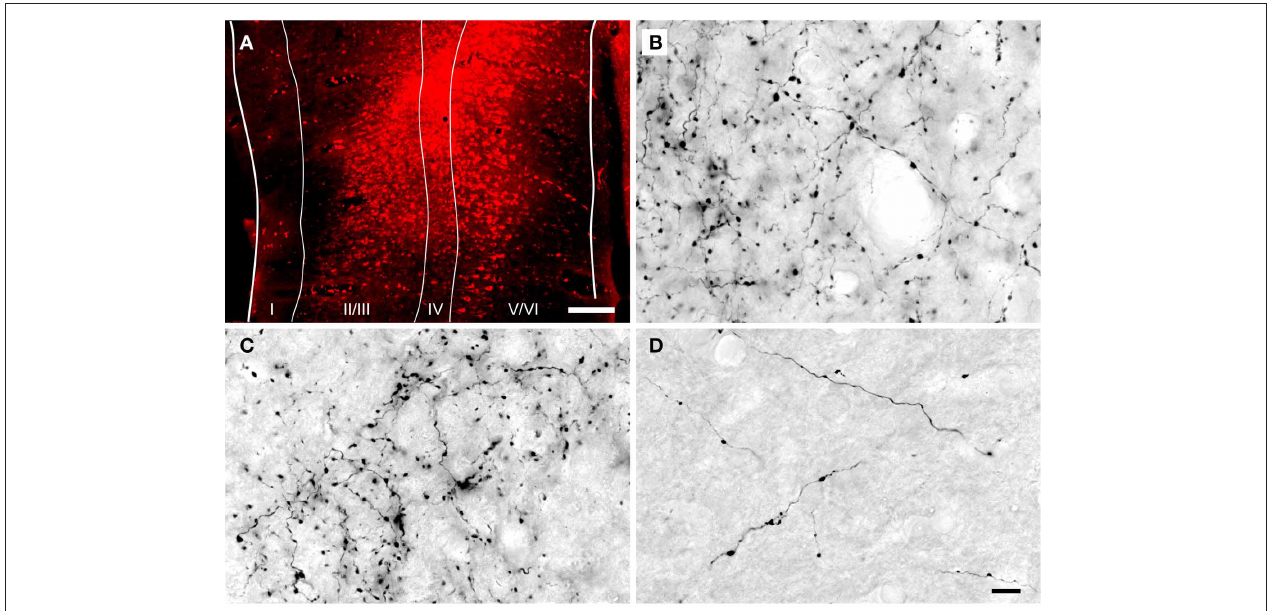
FIGURE 1 | Photomicrographs showing a representative injection into the auditory cortex and DAB-labeled cortical axons in the inferior colliculus. (A) Transverse section through a FluoroRuby (FR) deposit site in the left auditory cortex. The white lines indicate cortical layers I through VI. (B–D) Photomicrographs of DAB-labeled cortical axons in the dorsal cortex